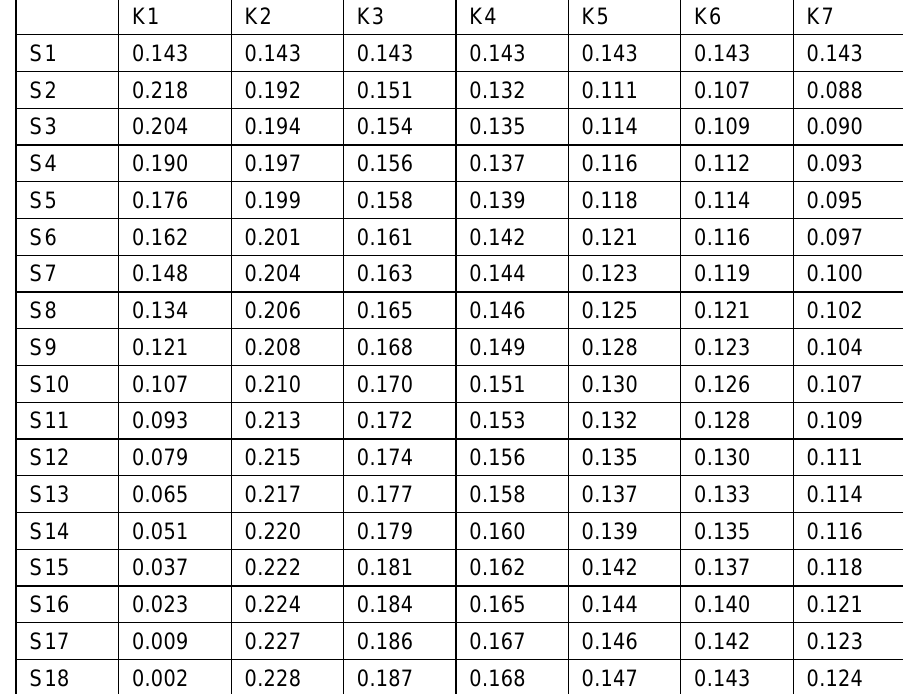
Table 5 – Scenarios of changes in the weight coefficients of the criteria Таблица 5 – Сценарии изменения весовых коэффициентов критериев Табела 5 – Сценарији промене тежинских коефицијената